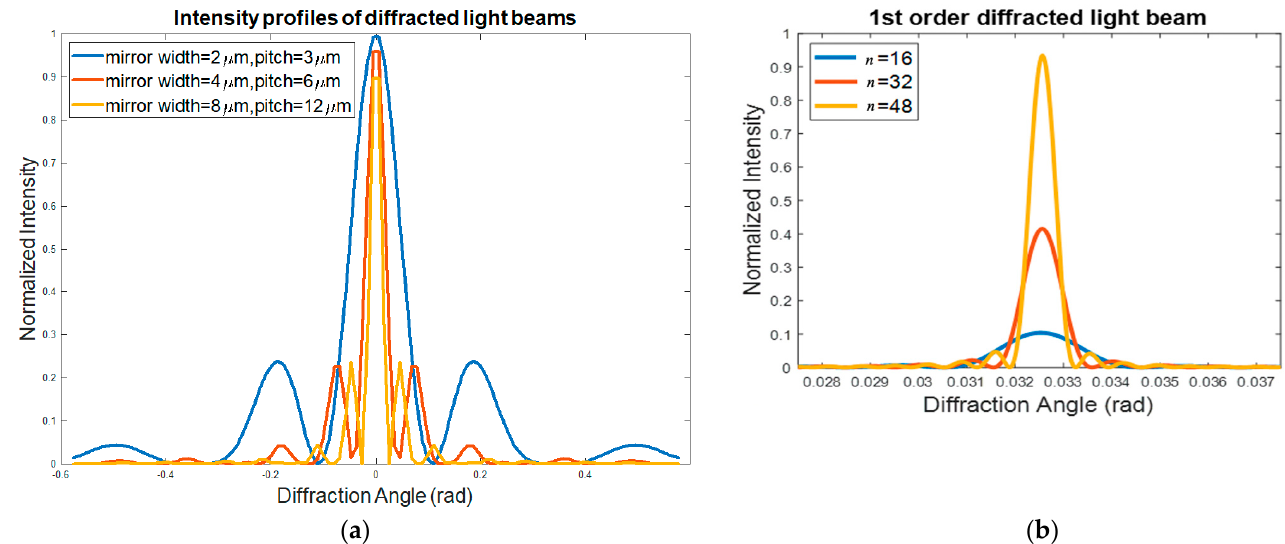
Figure 3. ( a ) Optical intensity profiles of total diffraction patterns in variation with OPA micromirror width and pitch; ( b ) 1 st -order diffracted light beam profile in variation with micromirror number in OPA system.